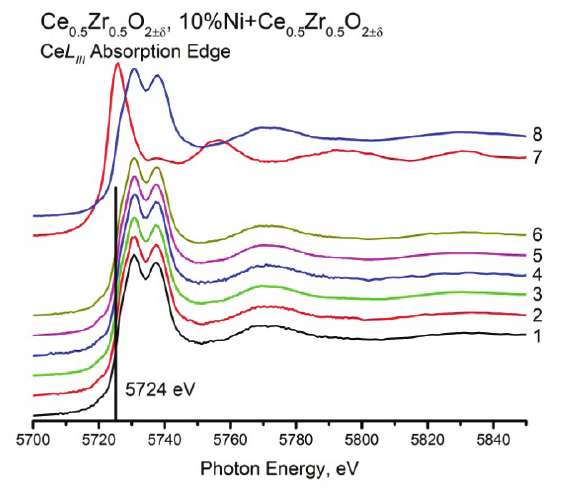
Zr O 800°C; 3 0.5 0.5 2±δ